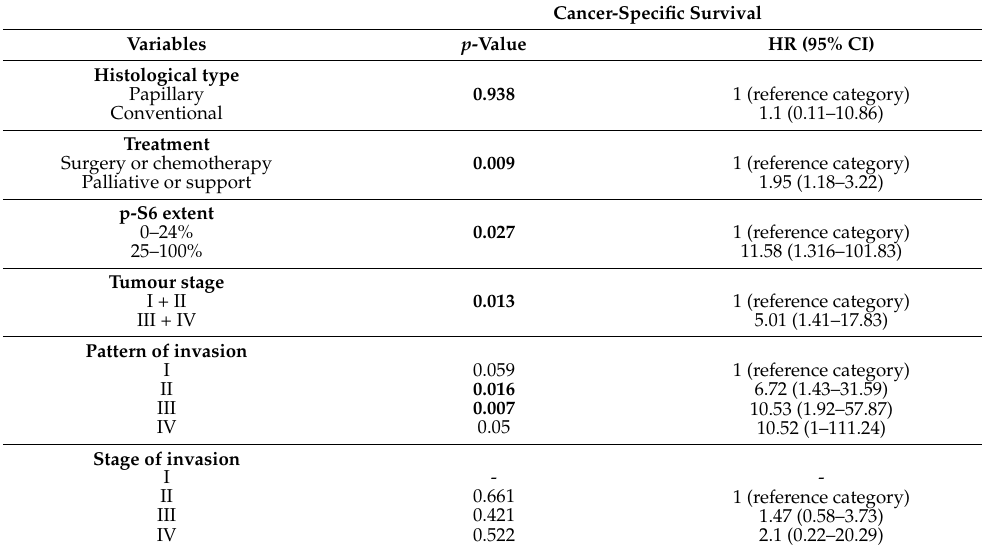
Figure 4. Kaplan Meier curves of CCS for p-mTOR and p-S6 extent and intensity scores. In multivariate analysis for CSS, we found an independent prognostic value for treatment, p-S6 extension and tumour stage, where dogs with tumours treated with palliative or support approach (HR 1.949; 95% CI, 1.178–3.223, p = 0.009), with tumours with high p-S6 expression (HR 11.577; 95% CI, 1.316–101.826, p = 0.027) or tumours with advanced tumour stage (HR 5.005; 95% CI, 1.405–17.829, p = 0.013) had more risk of dying comparing with the respective other categories of each variable (Table 6). Table 6. Multivariate analysis of the cancer-specific survival.